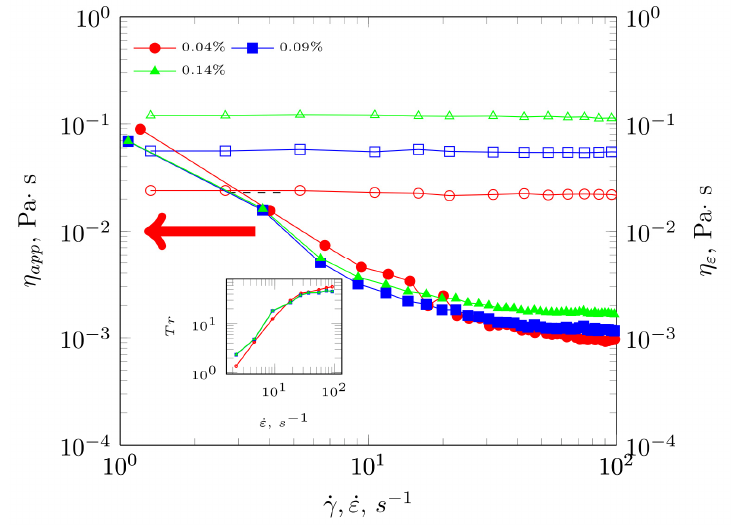
Figure 4. Comparison of changes in apparent viscosity against shear rate and extensional viscosity against extension rate for extracts in dilute regime. Table 2. Values of parameters of the modified DeKee and Papanastasiou model (values with the highest intensity are highlighted) and amount of ∆ E dissipated